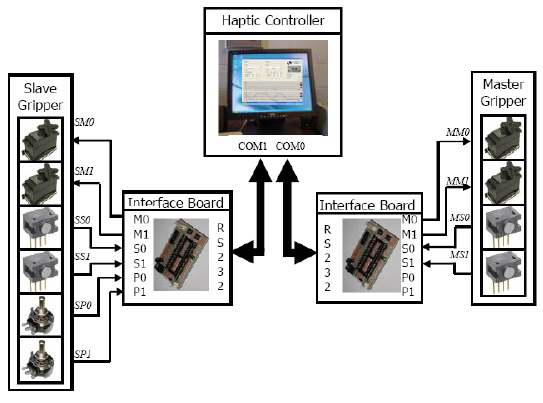
Fig. 2. Interface between the haptic controller with servomotors, sensors and